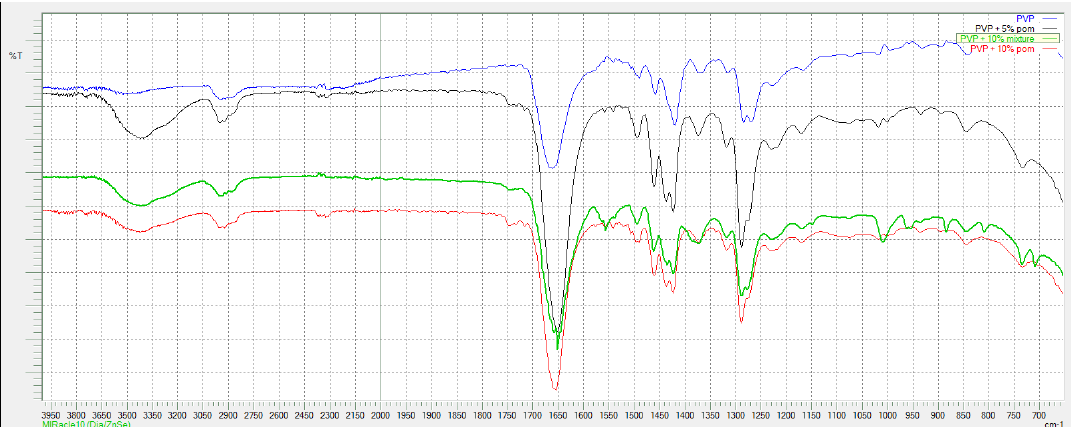
Figure 3. ATR-FTIR spectra of PVP, PVP-5PSO, PVP-10PSO, and PVP-5PSO5EP.